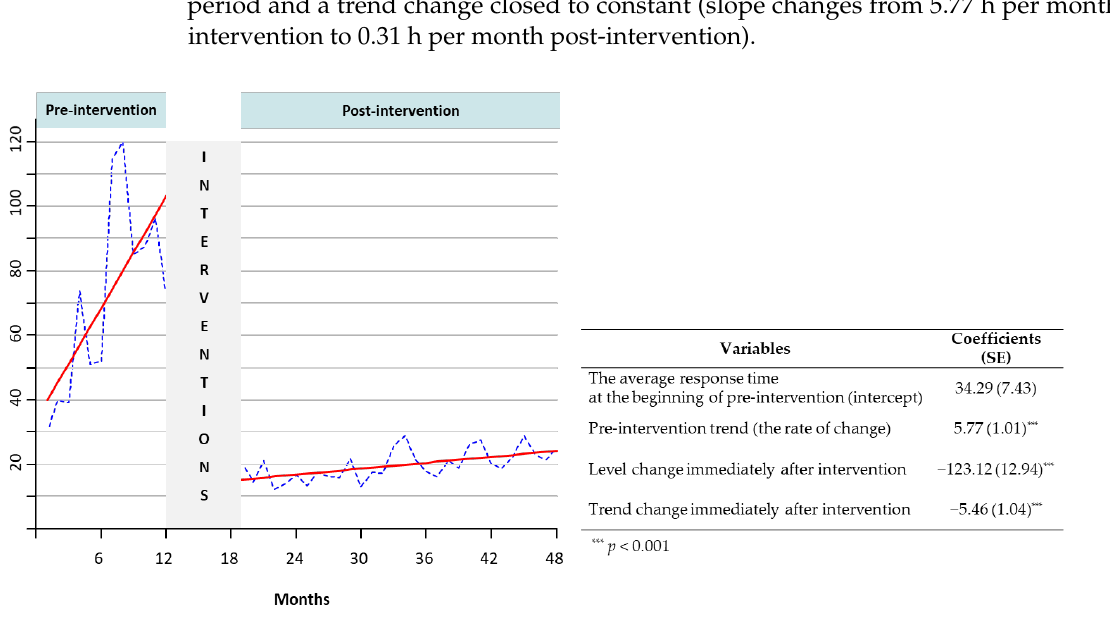
Figure 5. Pre- and post-intervention monthly response times (hours) of the nutrition support team (NST) physicians.